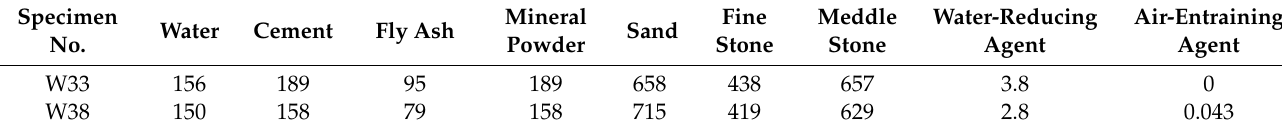
Table 2. Concrete aggregate ratio (kg/m 3